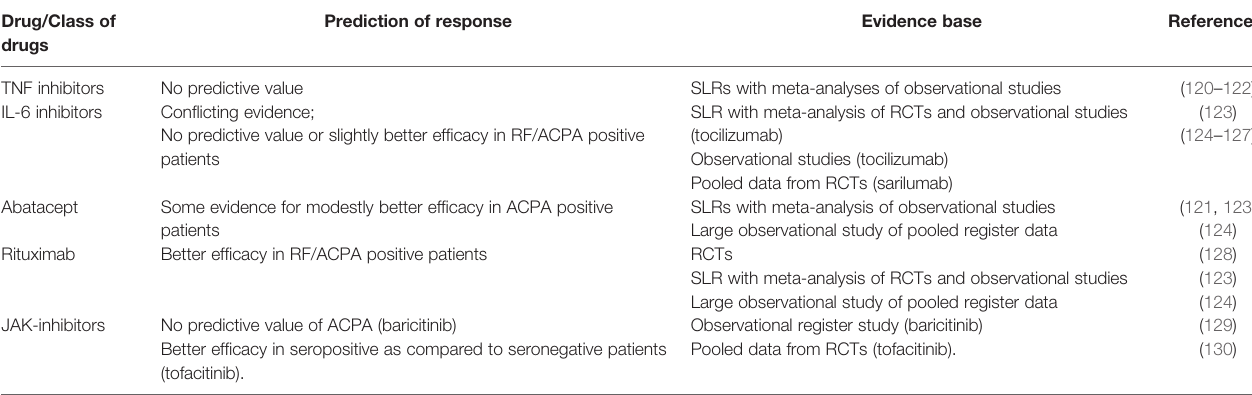
TABLE 1 | Summary of evidence for predictive value of ACPA and RF for outcome of treatment with bDMARDs and tsDMARDs in rheumatoid arthritis. Drug/Class of Prediction of response drugs